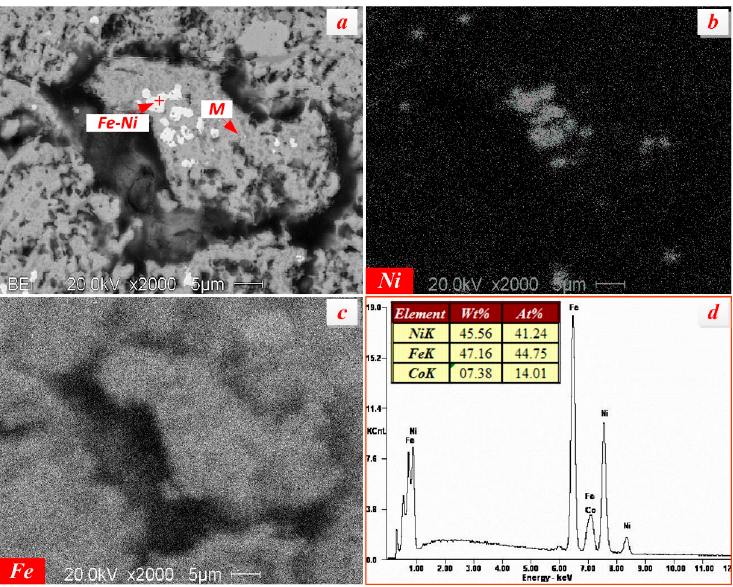
Figure 12. SEM image and EDS elemental maps of Ni-bearing minerals in nickel slag (M—magnetite; ( a )—Backscattered photomicrograph of the alloys displaying the fine grain size; ( b )—surface scanning images of Ni; ( c )—surface scanning images of Fe; ( d )—EDS pattern of Fe-Ni alloy).